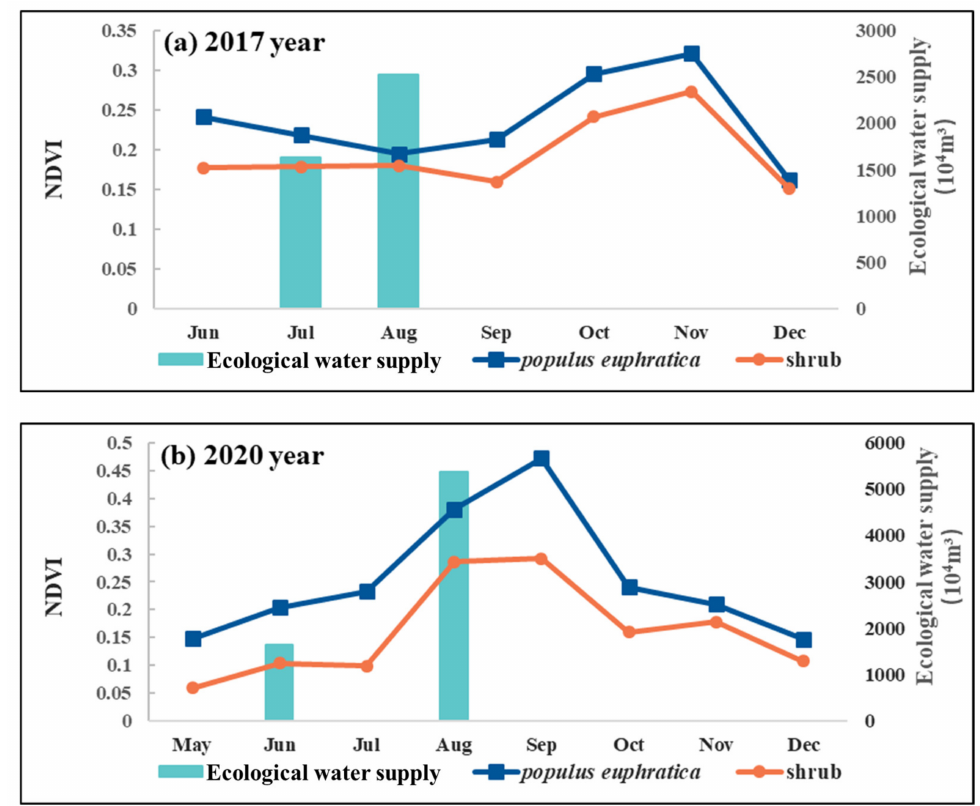
Figure 8. Changes in NDVI of the natural vegetation of Eichmann Lake before and after water delivery in 2017 ( a ) and 2020 ( b